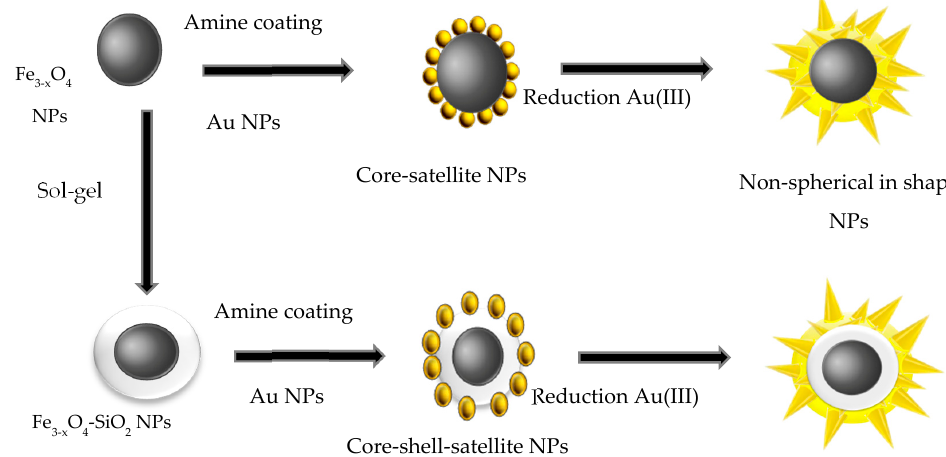
Figure 9. Schematic overview of the formation of non-spherical in shape core-shell structures via seed-mediated method.